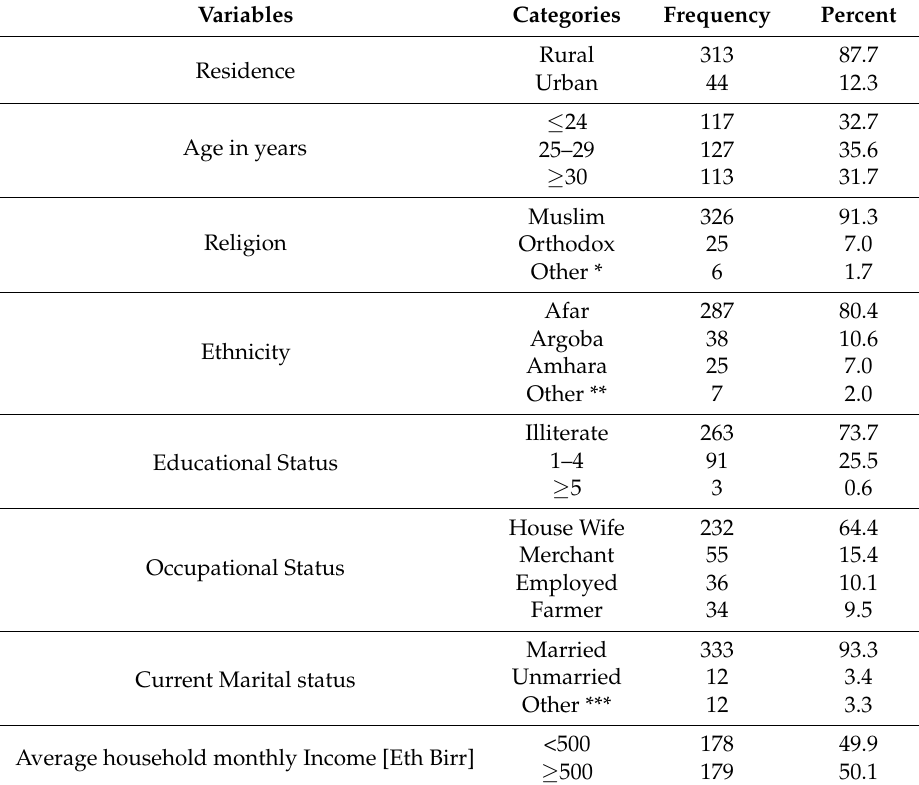
Table 1. Pregnant women’s socio-demographic characteristics in Gabi-Rasu zone of Afar region, Ethiopia, 2016 ( n =